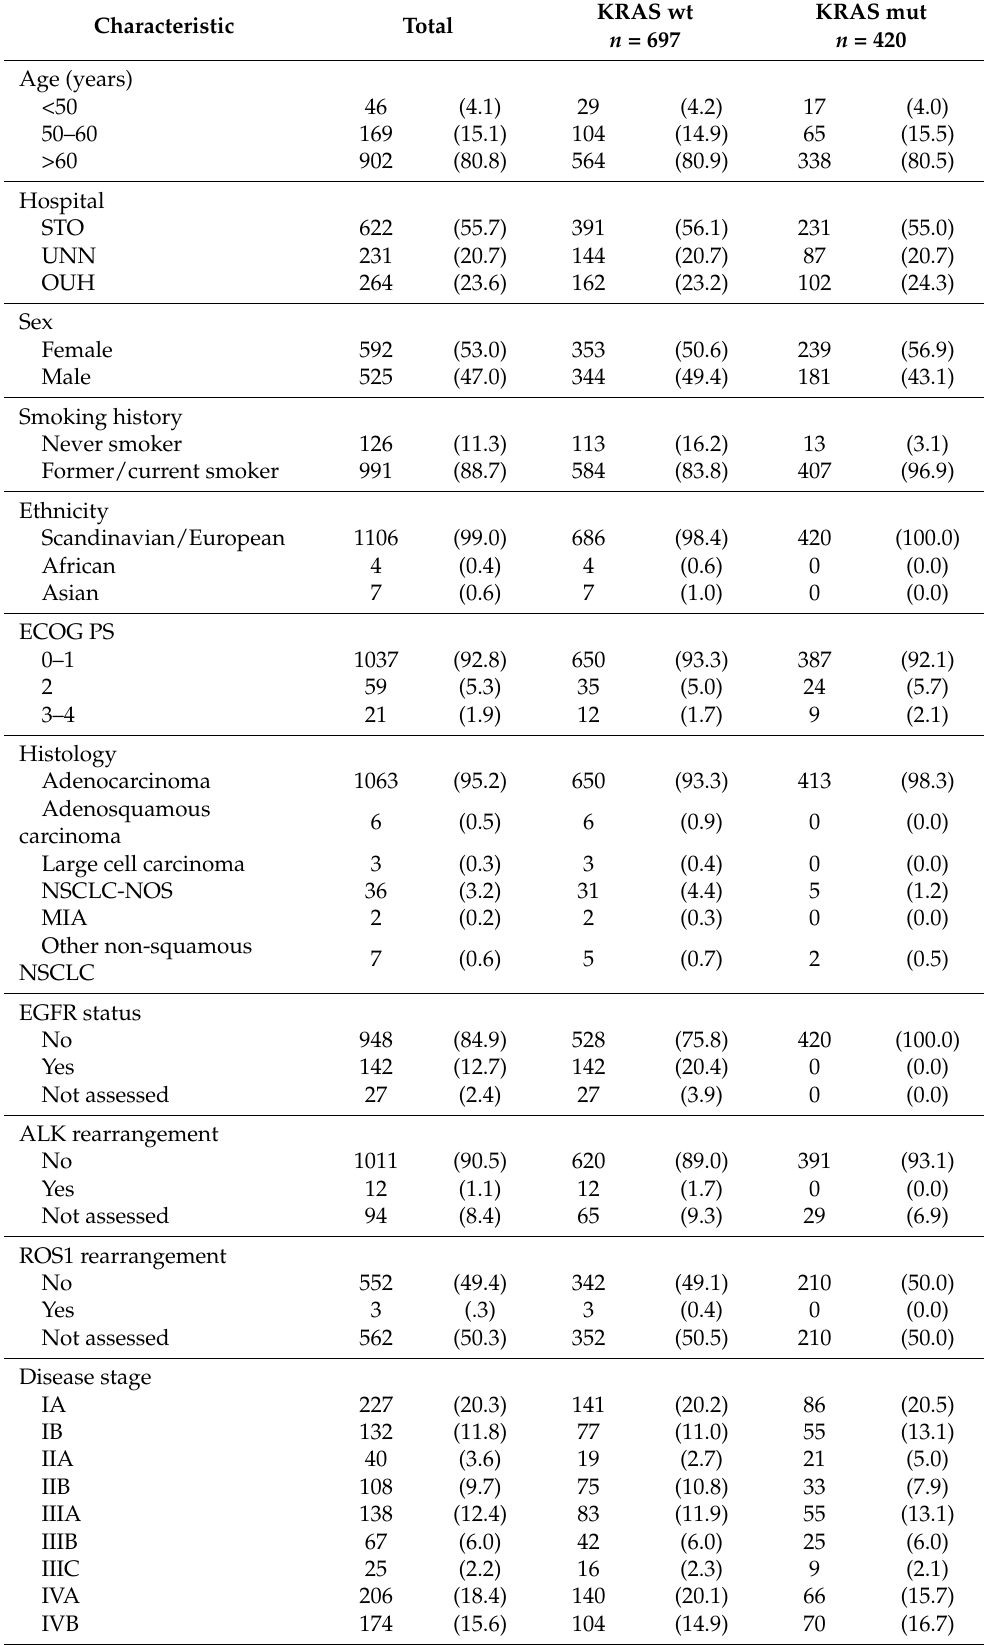
Table 1. Baseline patient characteristics according to KRAS